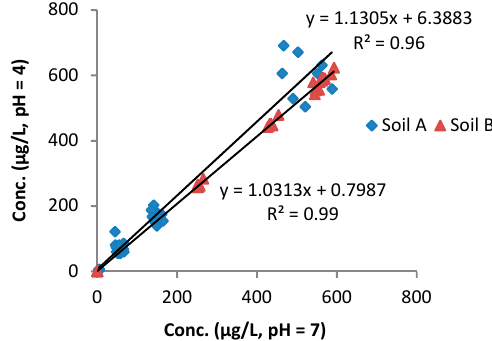
Figure 10. Comparison of concentrations of particulate heavy metals and metalloids (HMs) from soil A and soil B under the neutral (pH = 7) and acid (pH= 4) rainfall conditions.